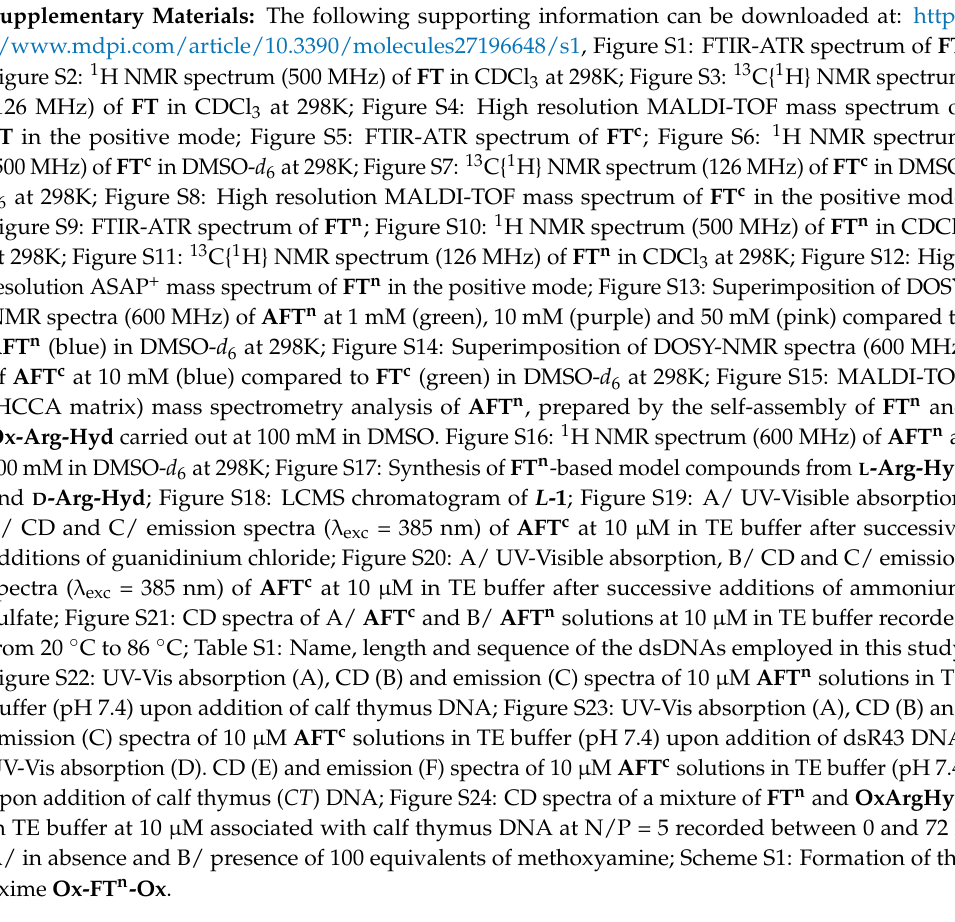
Figure S2: 1 H NMR spectrum (500 MHz) of FT in CDCl 3 at 298K; Figure S3: 13 C{ 1 H} NMR spectrum (126 MHz) of FT in CDCl 3 at 298K; Figure S4: High resolution MALDI-TOF mass spectrum of FT in the positive mode; Figure S5: FTIR-ATR spectrum of FT c ; Figure S6: 1 H NMR spectrum (500 MHz) of FT c in DMSO- d 6 at 298K; Figure S7: 13 C{ 1 H} NMR spectrum (126 MHz) of FT c in DMSO- d 6 at 298K; Figure S8: High resolution MALDI-TOF mass spectrum of FT c in the positive mode; Figure S9: FTIR-ATR spectrum of FT n ; Figure S10: 1 H NMR spectrum (500 MHz) of FT n in CDCl 3 at 298K; Figure S11: 13 C{ 1 H} NMR spectrum (126 MHz) of FT n in CDCl 3 at 298K; Figure S12: High resolution ASAP + mass spectrum of FT n in the positive mode; Figure S13: Superimposition of DOSY- NMR spectra (600 MHz) of AFT n at 1 mM (green), 10 mM (purple) and 50 mM (pink) compared to AFT n (blue) in DMSO- d 6 at 298K; Figure S14: Superimposition of DOSY-NMR spectra (600 MHz) of AFT c at 10 mM (blue) compared to FT c (green) in DMSO- d 6 at 298K; Figure S15: MALDI-TOF (HCCA matrix) mass spectrometry analysis of AFT n , prepared by the self-assembly of FT n and Ox-Arg-Hyd carried out at 100 mM in DMSO. Figure S16: 1 H NMR spectrum (600 MHz) of AFT n at 100 mM in DMSO- d 6 at 298K; Figure S17: Synthesis of FT n -based model compounds from L -Arg-Hyd and D -Arg-Hyd ; Figure S18: LCMS chromatogram of L -1 ; Figure S19: A/ UV-Visible absorption, B/ CD and C/ emission spectra ( λ exc = 385 nm) of AFT c at 10 µ M in TE buffer after successive additions of guanidinium chloride; Figure S20: A/ UV-Visible absorption, B/ CD and C/ emission spectra ( λ exc = 385 nm) of AFT c at 10 µ M in TE buffer after successive additions of ammonium sulfate; Figure S21: CD spectra of A/ AFT c and B/ AFT n solutions at 10 µ M in TE buffer recorded from 20 ◦ C to 86 ◦ C; Table S1: Name, length and sequence of the dsDNAs employed in this study; Figure S22: UV-Vis absorption (A), CD (B) and emission (C) spectra of 10 µ M AFT n solutions in TE buffer (pH 7.4) upon addition of calf thymus DNA; Figure S23: UV-Vis absorption (A), CD (B) and emission (C) spectra of 10 µ M AFT c solutions in TE buffer (pH 7.4) upon addition of dsR43 DNA; UV-Vis absorption (D). CD (E) and emission (F) spectra of 10 µ M AFT c solutions in TE buffer (pH 7.4) upon addition of calf thymus ( CT ) DNA; Figure S24: CD spectra of a mixture of FT n and OxArgHyd in TE buffer at 10 µ M associated with calf thymus DNA at N/P = 5 recorded between 0 and 72 h A/ in absence and B/ presence of 100 equivalents of methoxyamine; Scheme S1: Formation of the oxime Ox-FT n -Ox